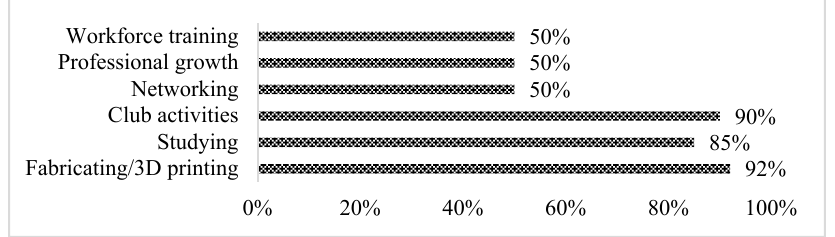
Figure 15. Percent of respondents ranking each item in their top three .